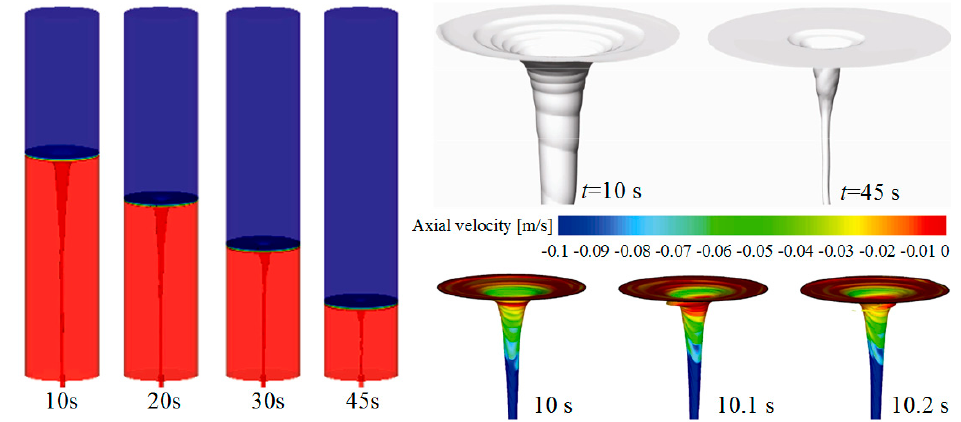
Figure 6. Evolving course of the free surface vortex. (Reprinted with permission from Ref. [68]. 2015, Springer Nature).